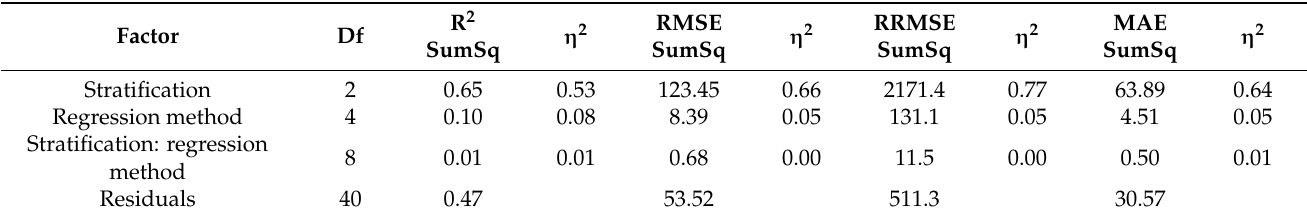
Table 9. ANOVA of the R 2 , RMSE, RRMSE and MAE respective to the stratification method, regression method and their